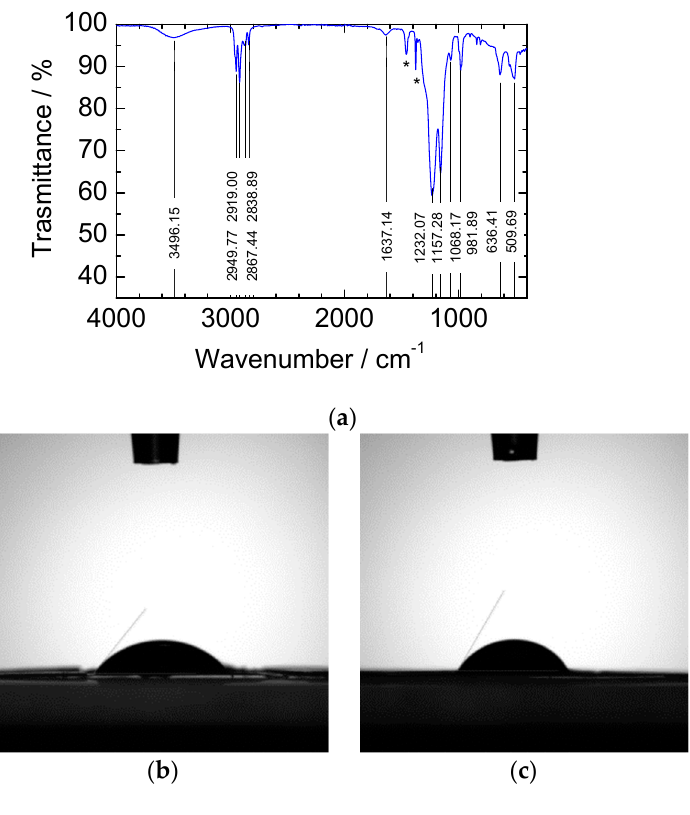
Figure 4. SEM images of the cross-section of the pressed electrode/CN01 separator assembly.